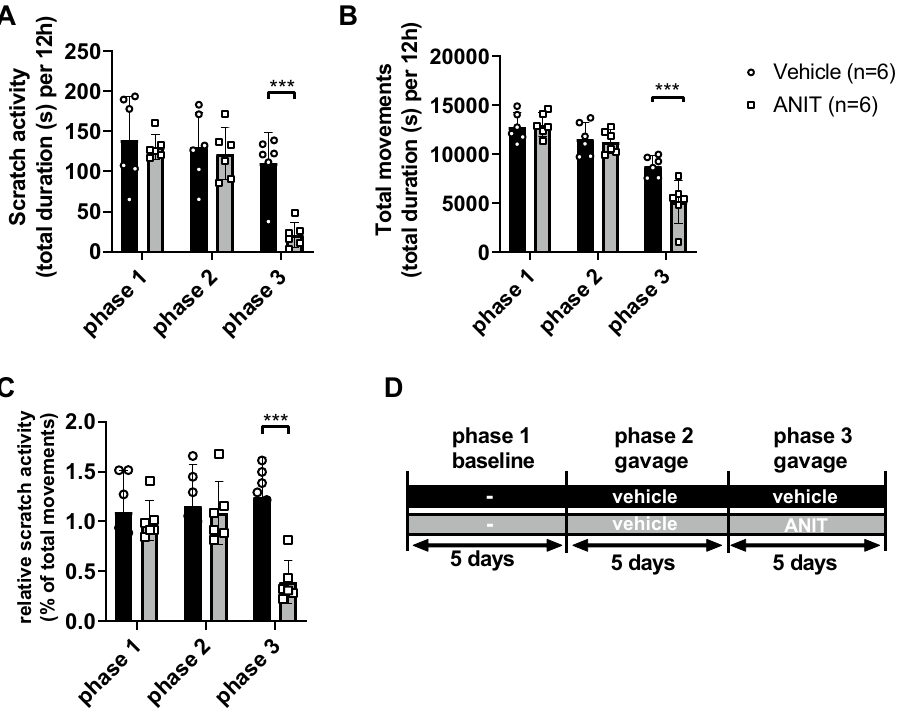
Figure 2. Scratch activity ( A ), total movements ( B ) and relative scratch activity as percentage of total movements ( C ) in WT mice during baseline (phase 1), gavage with vehicle (phase 2) and after treatment with vehicle (n = 6) or ANIT (n = 6) (phase 3). Panel ( D ) shows the experimental setup. Each bar represents the mean of six mice over five days ± SD. Statistics: two-way ANOVA followed by Sidak’s post hoc test. *** p -value <